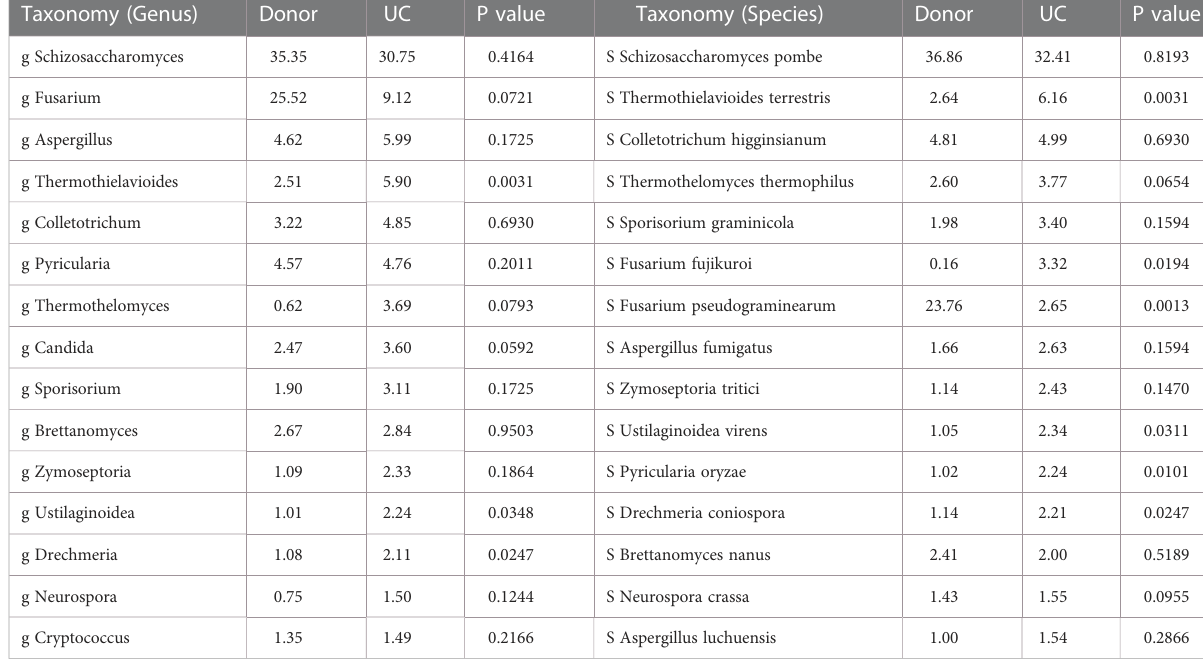
TABLE 2 Comparison of the main taxonomy of fungi in donor and UC patients. Taxonomy